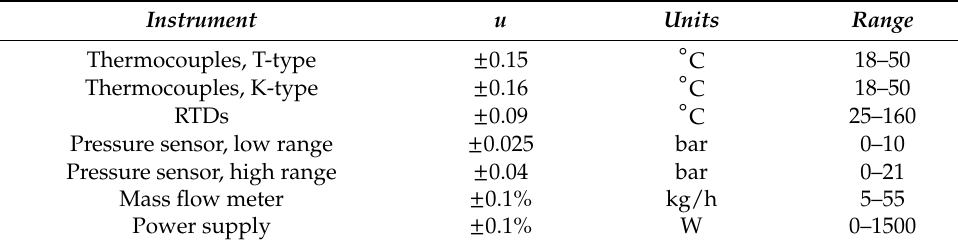
Figure 1. The experimental setup: ( a ) Schematic diagram of the experimental loop, ( b ) Schematic representation of the parts of the test section. Table 2. Instrument type and expanded